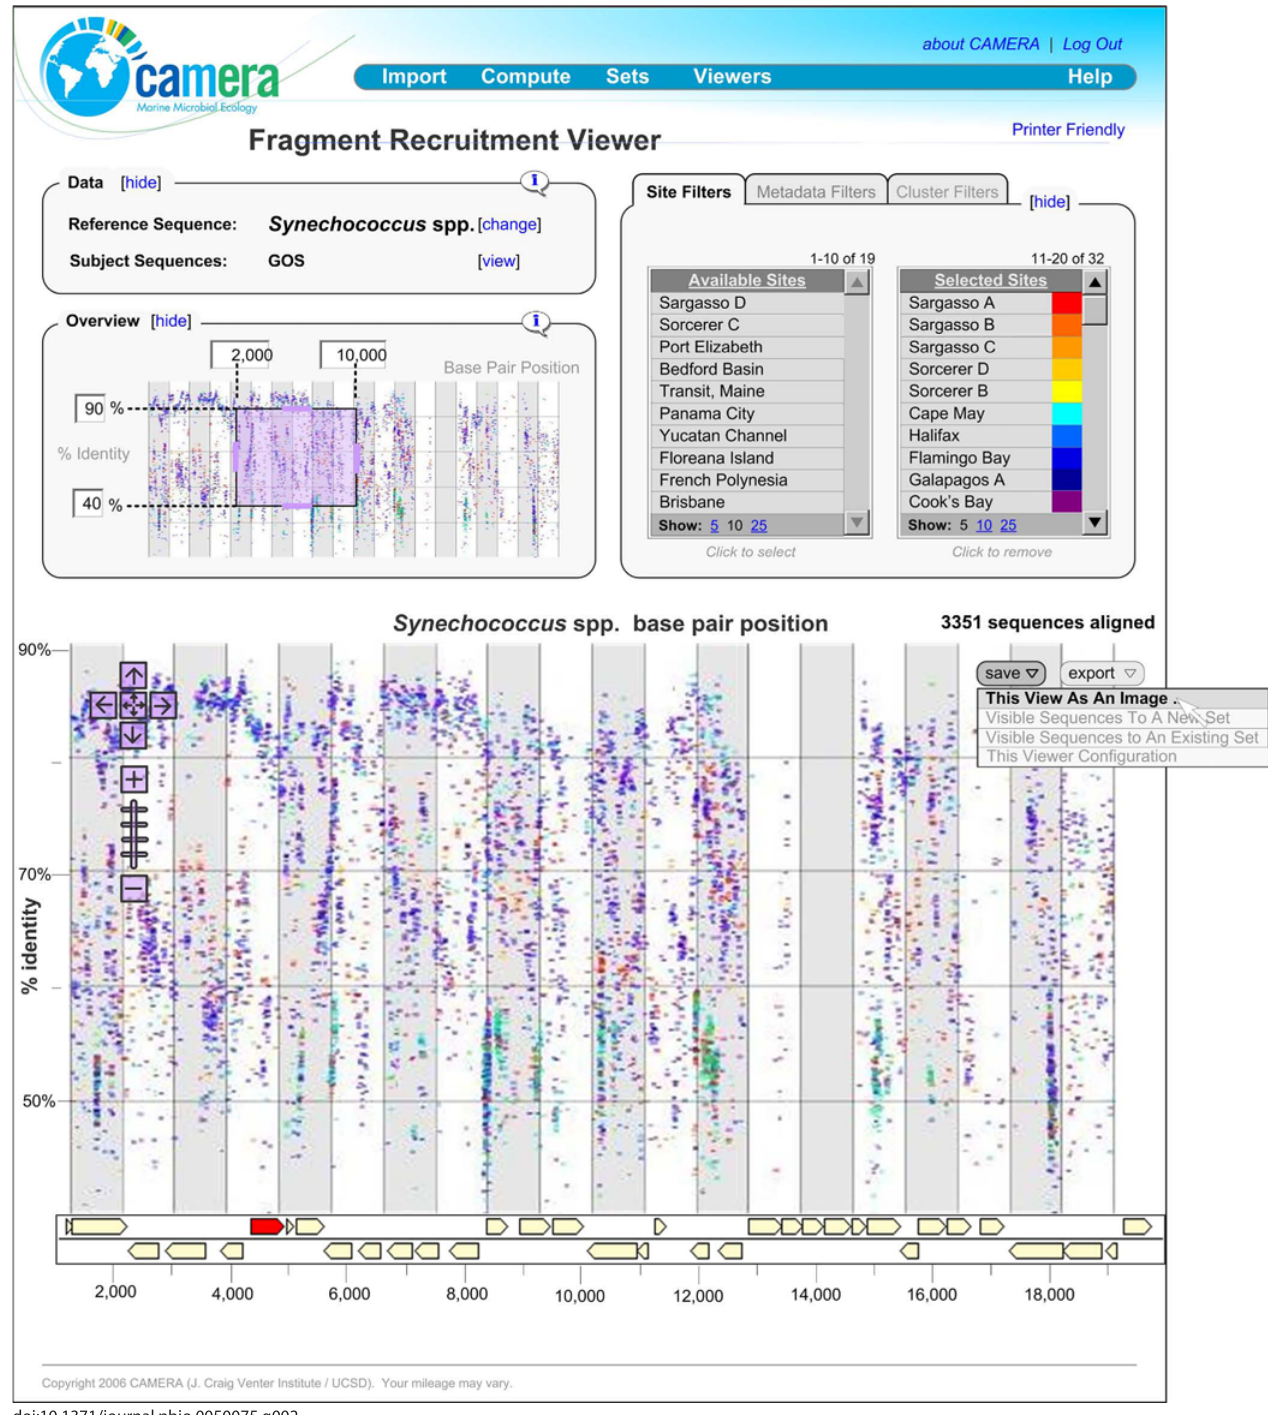
Figure 2. CAMERA Fragment Recruitment Viewer This tool graphically displays the results of a BLASTN sequence comparison of an available microbial genome against selected sequence read datasets. The example shown displays the abundance and distribution of Synechococcus spp. genome sequence in the selected sampling sites. The Synechococcus spp. genome coordinates are shown on the x -axis, while the y -axis shows the percent identity scores of the alignment to the selected Sargasso Sea and GOS sequence reads. The viewer incorporates metadata associated with the reads, allowing a user to quickly identify data of interest for further examination. The utility of the plot is to examine the biogeography and genomic variation of abundant microbes when a close reference genome